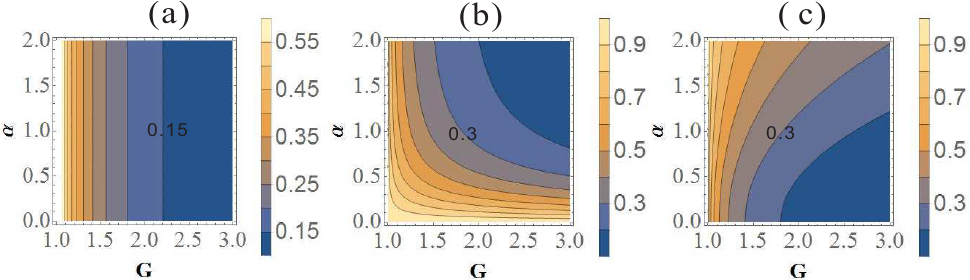
Figure 7. The dependence of ( a ) T s − 12 ; ( b ) T 1 − s 2 ; and ( c ) T 2 − s 1